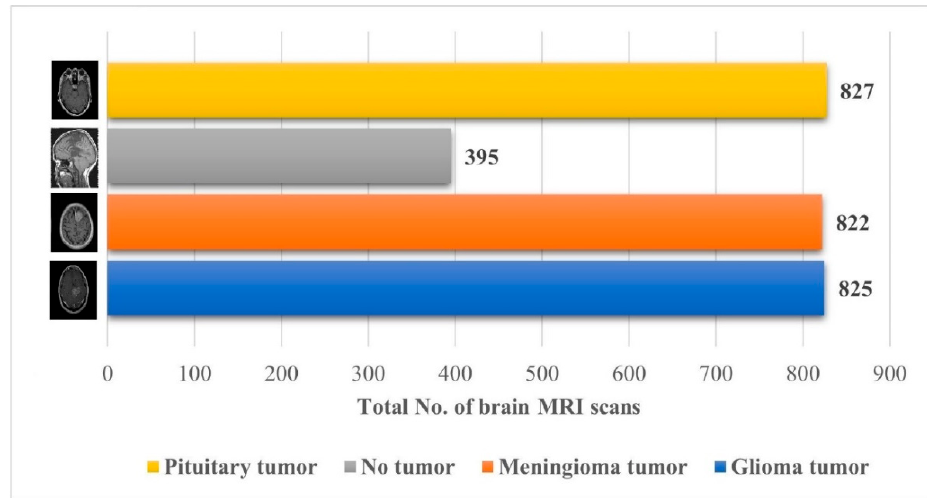
Figure 2. Details about the Kaggle “Brain Tumor Classification (MRI)” dataset [32] .